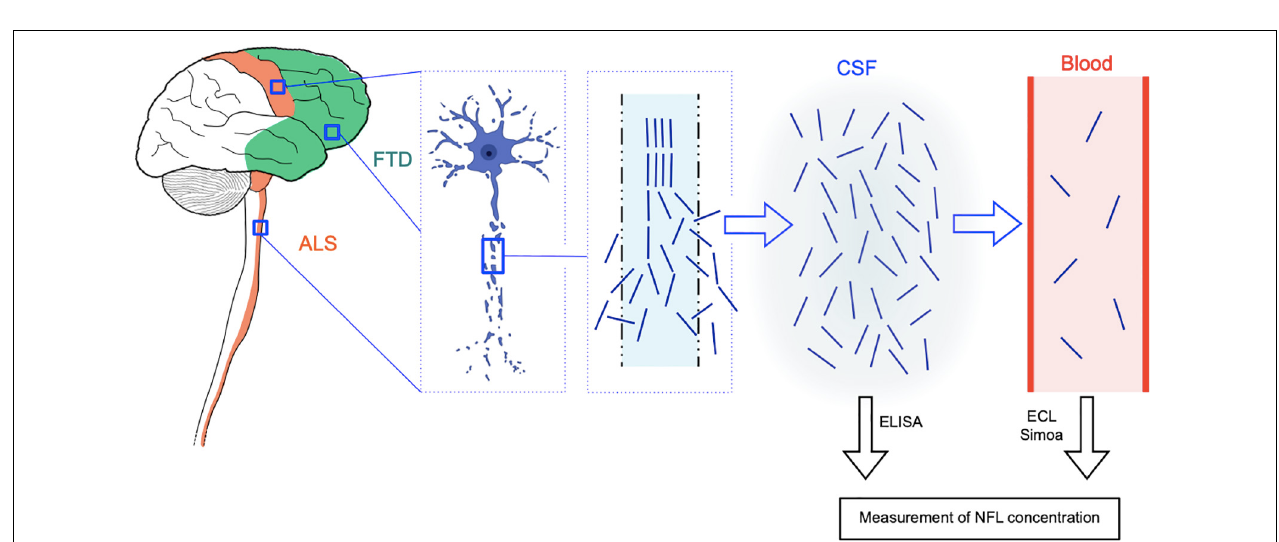
FIGURE 3 | Rationale of NFL as CSF and blood biomarker for ALS and FTD. ALS is characterized by degeneration of upper motor neurons of the motor cortex and of lower motor neurons of the brainstem and spinal cord, while in FTD, the disease process affects neurons of the frontal and temporal cortices. In both diseases, neuroaxonal degeneration causes the release of neurofilament (and in particular NFL) molecules from the axon to the interstitial fluid and hence to the CSF and finally to the blood, where they are present at much lower concentrations (approximate CSF:blood ratio for NFL: 40:1). NFL levels in the CSF can be quantified by means of conventional ELISA assays, while more sensitive techniques are needed for the measurement of the lower blood (serum or plasma) levels, i.e., electrochemiluminescence (ECL) and the ultrasensitive single molecule array (Simoa) technology. The image of the degenerating neuron was taken from BioRender.com